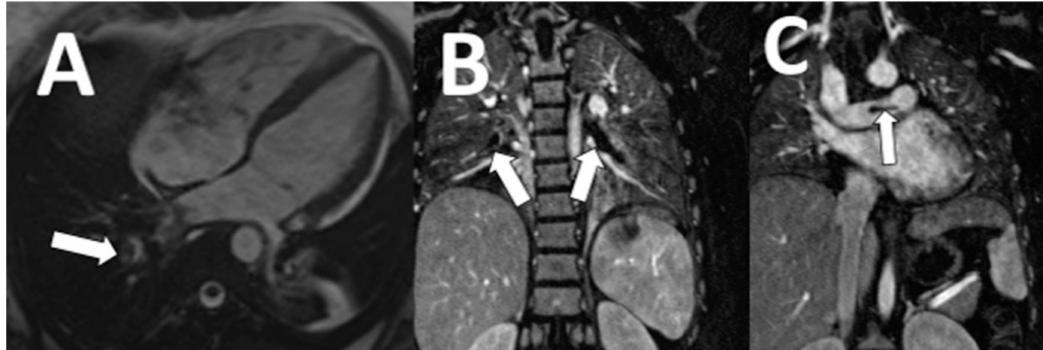
Figure 4. A 49-year-old woman underwent CMR for diagnosis of cardiomyopathy. Unexpectedly identified pulmonary thromboembolism in the right and left pulmonary arteries are demonstrated on white blood image ( A : arrow) and coronal thoracic MRA ( B , C : arrows).